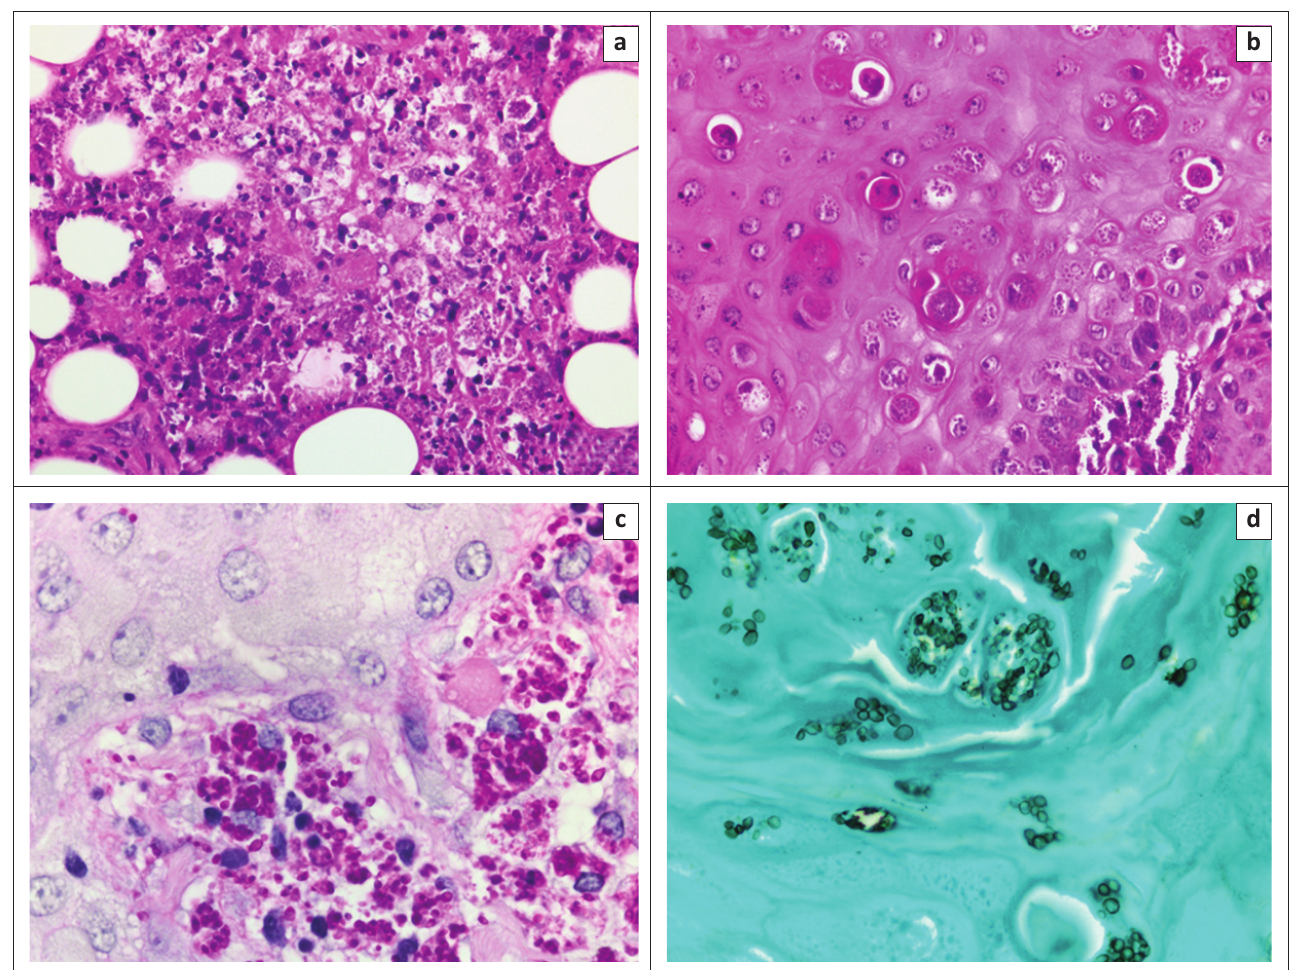
FIGURE 2: Histopathology of presumed Emergomyces africanus infection, with (a) deep dermal and superficial subcutaneous histiocytic and neutrophilic infiltrate in response to the fungal yeasts, with background karyorrhectic debris (haematoxylin and eosin, × 400); (b) pseudoepithelomatous hyperplasis and attempted transepidermal elimination of intracellular and extracellular yeasts (haematoxylin and eosin, × 400); (c) periodic acid-Schiff stain highlighting the predominantly intracellular organisms in the upper dermis (periodic acid-Schiff, × 1000); and (d) Gomori methamine silver stain confirming transepidermal elimination of extracellular yeasts into the stratum corneum (Gomori methamine silver, ×